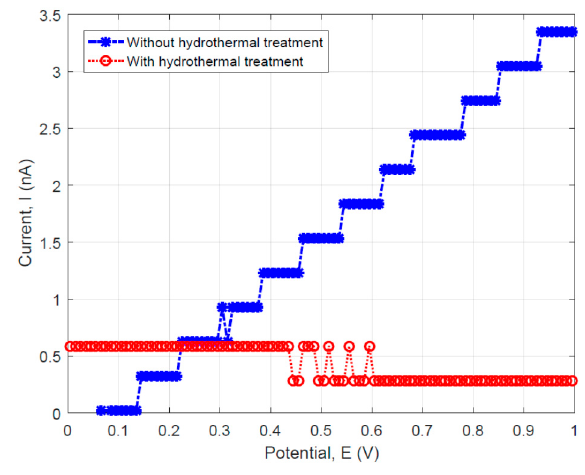
Figure 9. Linear sweep voltammetry results showing the I–V relationship for the specimens with and without hydrothermal carbonization treatment.